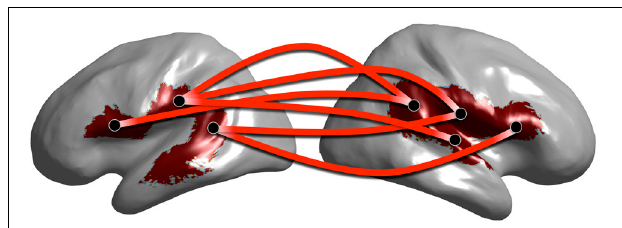
FIGURE 10 | Graph of alpha band network clusters over the arcuate fasciculus. Subset of full alpha band network depicting cluster centroids (black dots) overlaid on cluster locations on the cortical surface (red surface). Red lines between centroid locations indicate significant network